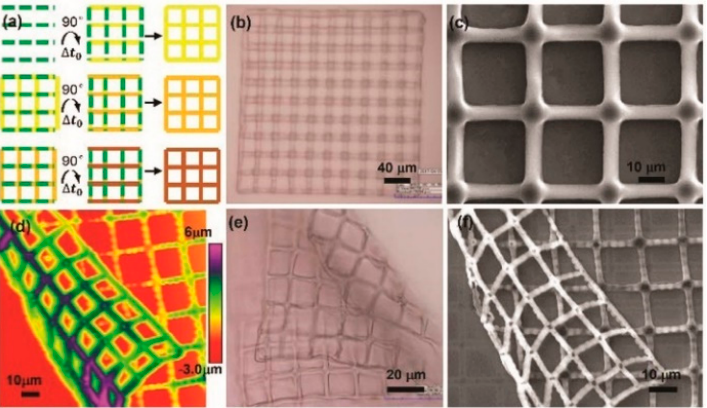
Figure 17. ( a ) Projected patterns alternating at a time interval ( Δ t 0 ); ( b – d ) are the optical microscope, SEM and AFM observation results, respectively; ( e , f ) are the optical microscope and SEM images of folded PEGDA hydrogel grids, respectively (reproduced from Ref. [84]).